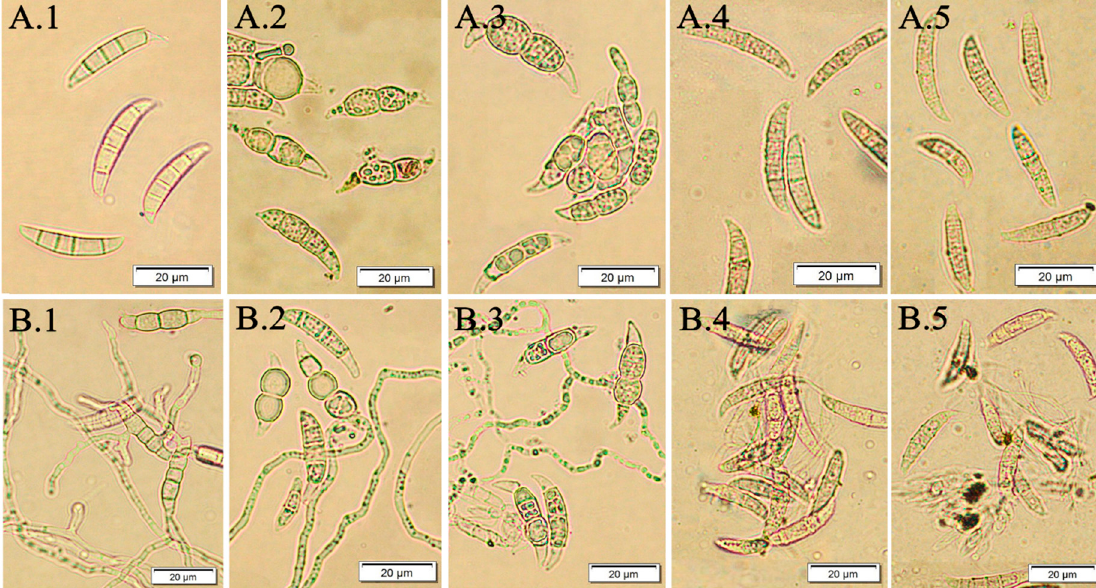
Figure 4. F. culmorum DEMFc37 treated with F. vesiculosus water extract (W.E) after 120 h of incubation; ( A ) non-germinated; ( B ) germinated macroconidia with hyphae of different length; (1) water control (W.C); (2) 0.05%; (3) 0.2%; (4) 0.5 %; (5) 1.0%.